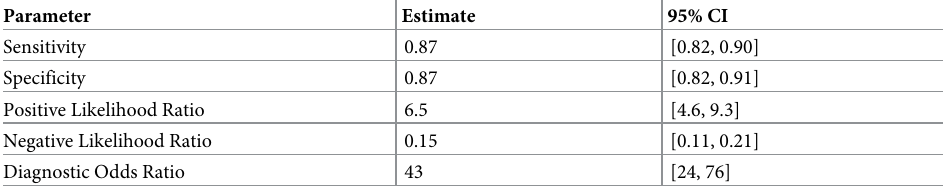
Table 4. Combined effect sizes for AI-assisted diagnostic systems for the diagnosis of lung cancer.